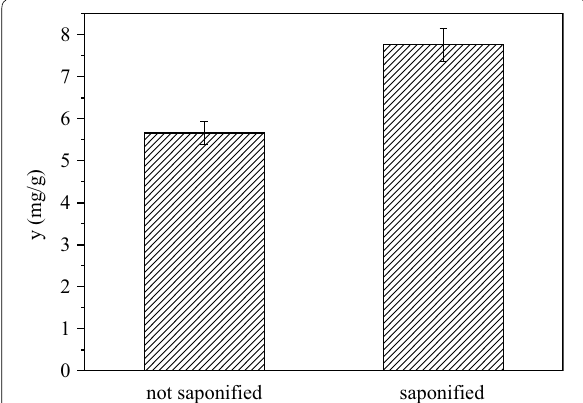
Fig. 2 Effects of the saponification on yield of phytosterols from